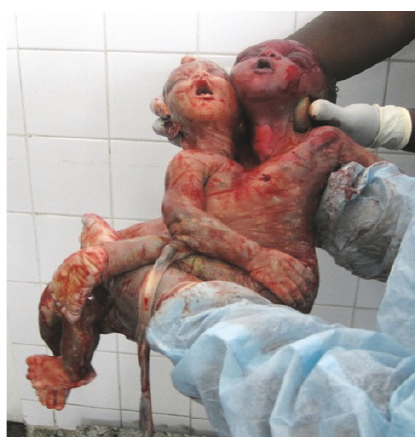
Figure 3: Stillborn thoracopagus-type conjoined